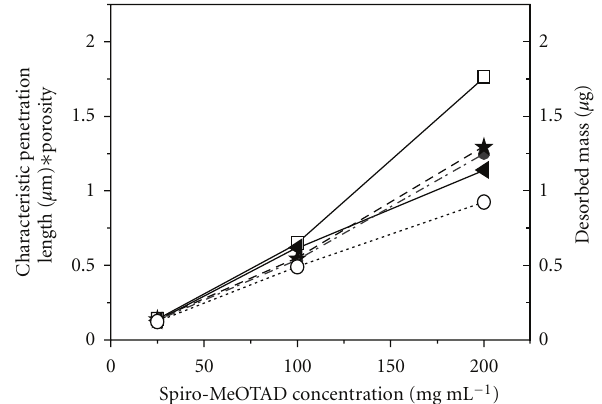
Figure 5: The scale of the CPL ( μ m), times the porosity (%), is the same as the one for the desorbed mass ( μ g) for spiro-OMeTAD with a density of 1g/cm 3 (see text). Average calculated and experimental values of the mass are plotted versus spiro-MeOTAD concentration. The experimentally determined mass desorbed from the samples ( (cid:5) ) is much lower than the calculated total mass ( (cid:6) ) and should be greater than the calculated mass in the pores ( (cid:7) ) because the former also includes the overlayer. The uncorrected CPL ( • ) is equal to the calculated mass in the pores ( (cid:7) ). These values indicate that the filling fraction overestimates the amount of spiro- MeOTAD which actually infiltrates the pores. The correction for viscosity e ff ects ( (cid:6) ) for higher concentrations of spiro-MeOTAD gives an improved value for the CPL, or calculated mass in the pores. (The standard deviation of all CPL and desorbed mass values is < 0.12 μ